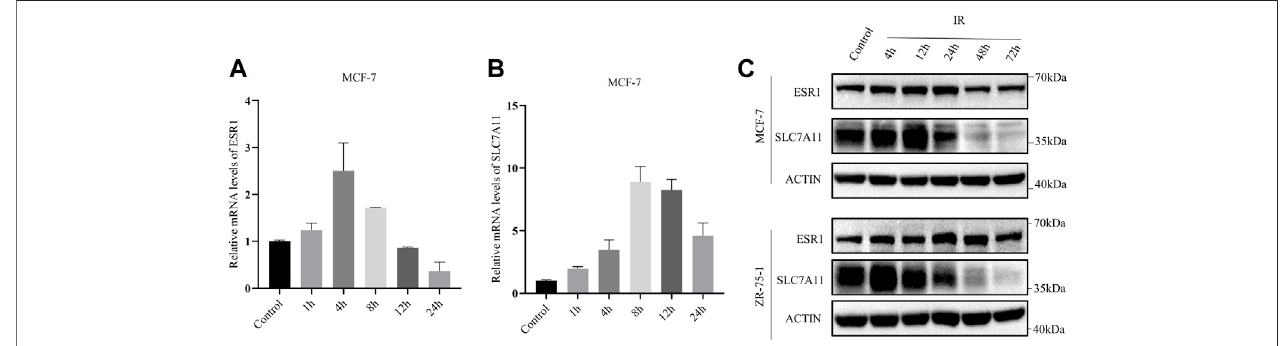
FIGURE4| IR-inducedSLC7A11andESR1expression inER-positivecelllines.Cellswerecollectedatdifferenttimepointsafter IRwith8Gyx-rays. Westernblot, and qRT-PCR were used to detect the expression of SLC7A11 and ESR1. (A,B) Relative mRNA expression of ESR1 (A) and SLC7A11 (B) were detected in MCF-7. Shown is mean ± SD. (C) SLC7A11 and ESR1 protein expression by IR treated in MCF-7 and